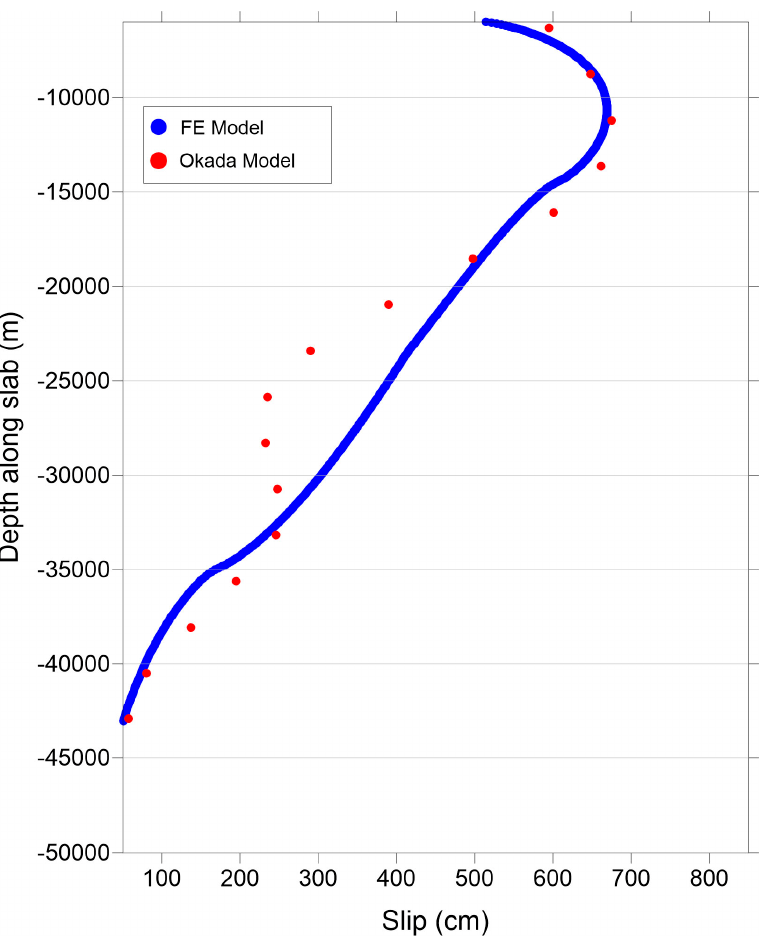
Figure A3. Comparison between the slip values retrieved from FE model and Okada solution. Note how the variation of the slip values with depth shows similar trend up to ~20 km depth, while they deviate from 22 to 33 km depth. This discrepancy may be ascribed to the curvature of the slab, which has been taken into account in the FE modeling only.